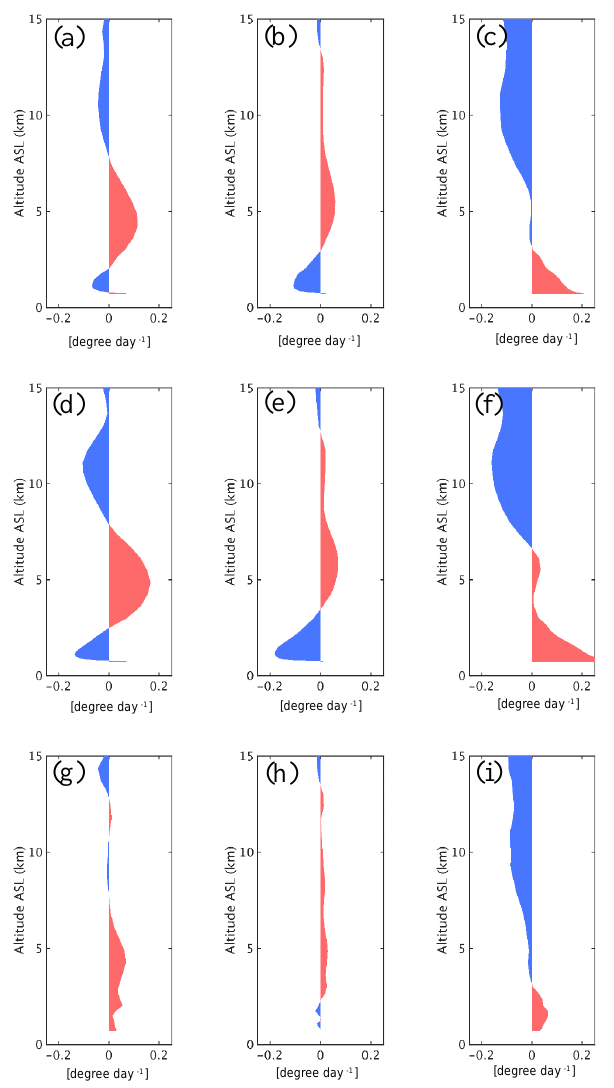
Figure 9. Modification of the vertical temperature profile induced by the full effects of dust (left panels), the direct radiative effect of dust (middle panels), and the semi-direct and indirect effects of dust (right panels) over the entire simulation domain (a–c) , over land (d– f) , and over ocean (g–i)